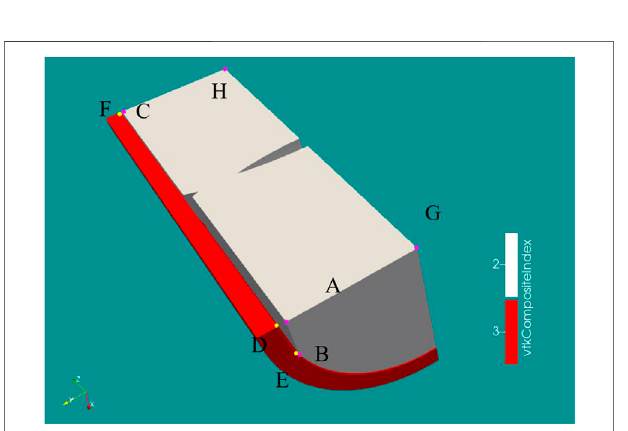
FIGURE 9 | Burnup distribution at point G in full irradiation